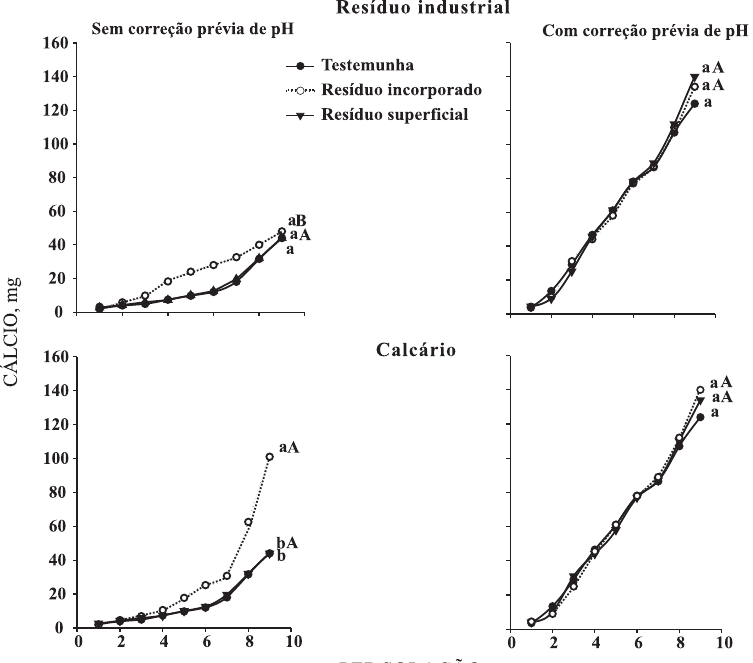
Figura 3. Perdas acumuladas de cálcio após 10 percolações com água destilada em decorrência da aplicação de calcário ou de um resíduo industrial em amostras de solo com e sem correção prévia de pH. (Letras minúsculas comparam as formas de aplicação de cada corretivo com a testemunha dentro de cada pH; letras maiúsculas comparam esses mesmos tratamentos entre os corretivos da acidez, dentro do mesmo pH. Ausência de letra significa inexistência de diferença estatística pela análise de contraste a 5 %).